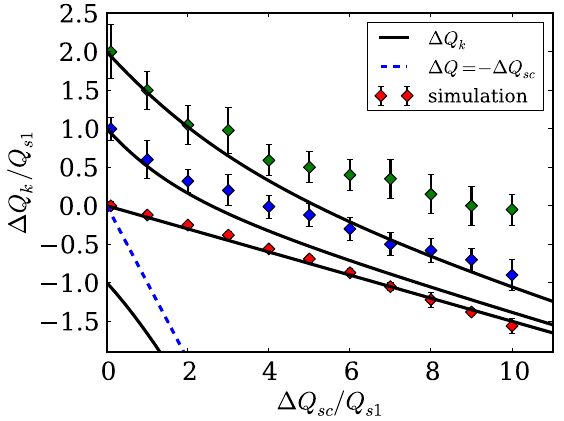
FIG. 3. Head-tail tune shifts and their width obtained from the simulations for q c ¼ 0 : 15 q sc . The error bars indicate the width of the peaks.